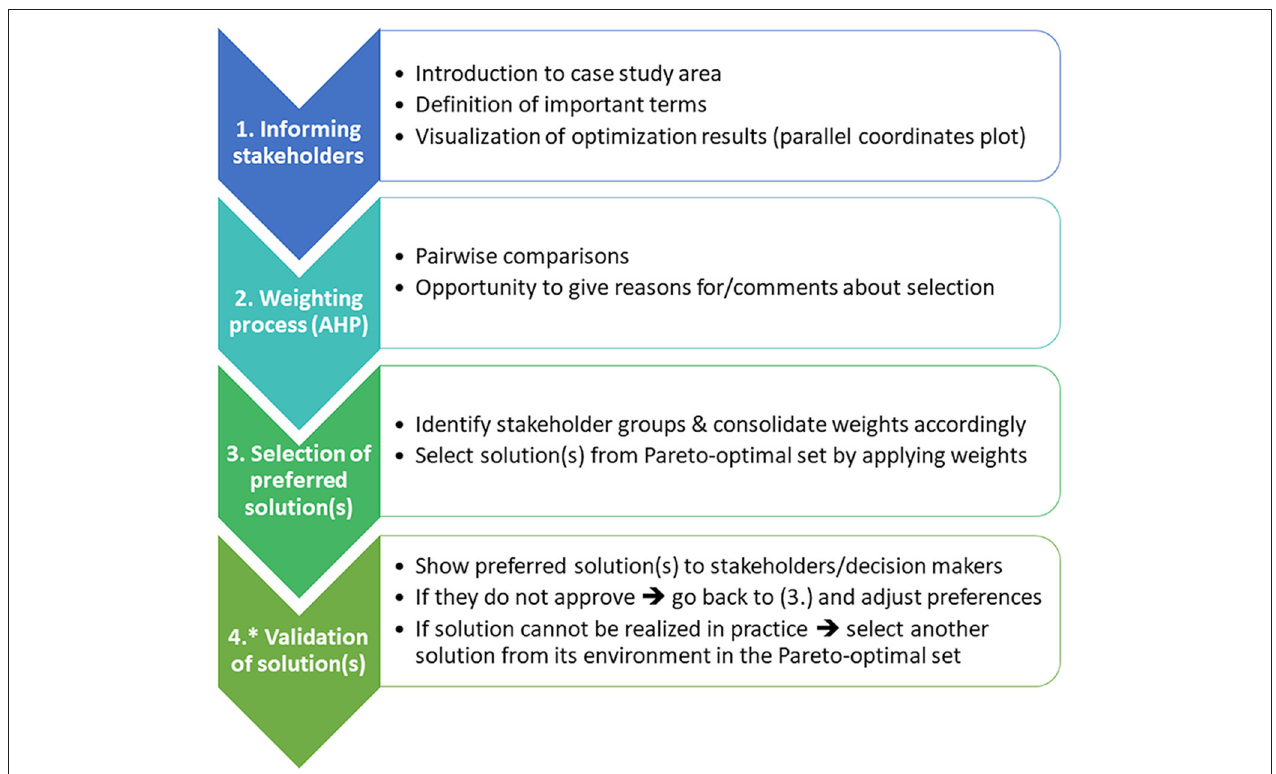
FIGURE 1 | Framework for the identification of preferred solutions from the set of Pareto-optimal solutions. Steps 1–3 were implemented in this research, 4* could be added in future